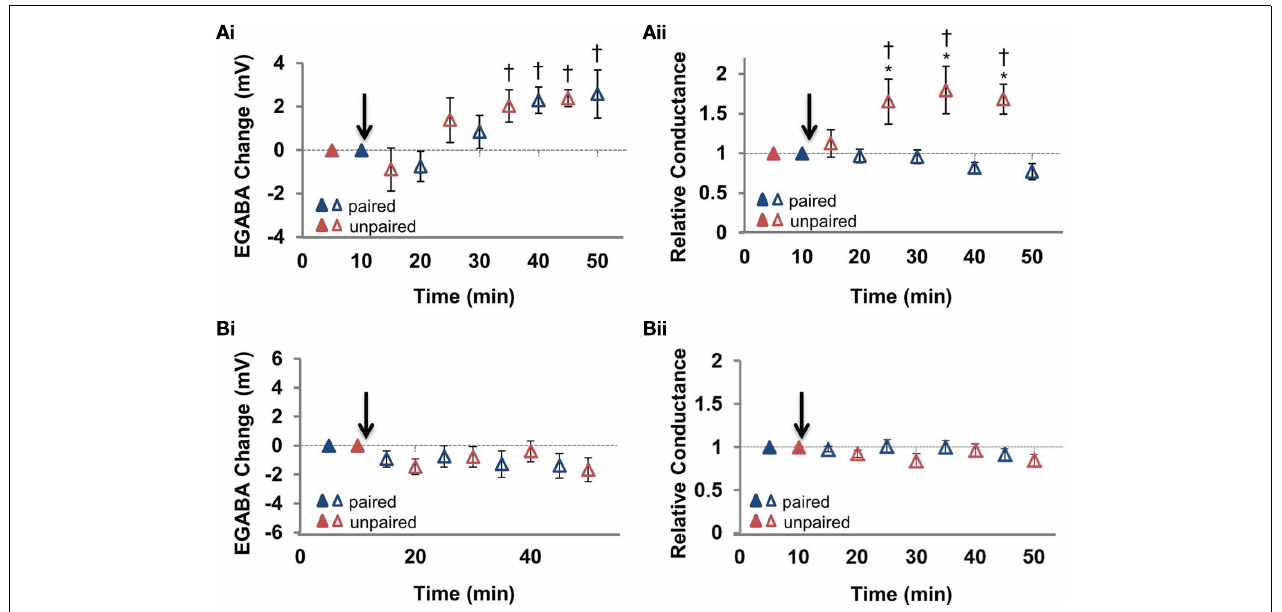
relative GABAergic conductance at the paired and unpaired pathways [for the same cells in (Ai) ]. Blue triangles denote paired pathways, red triangles denote unpaired pathways; filled triangles represent baseline recordings, open triangles represent recordings following plasticity induction. IPSP– V m curves were constructed at five time points, alternating between unpaired and paired pathways. Each of the five time points at the paired pathway were compared to the corresponding time point from the unpaired pathway.* Denotes statistical significance from unpaired pathway ( p < 0.05). † Denotes statistical significance from baseline ( p < 0.05). Paired activity denoted by